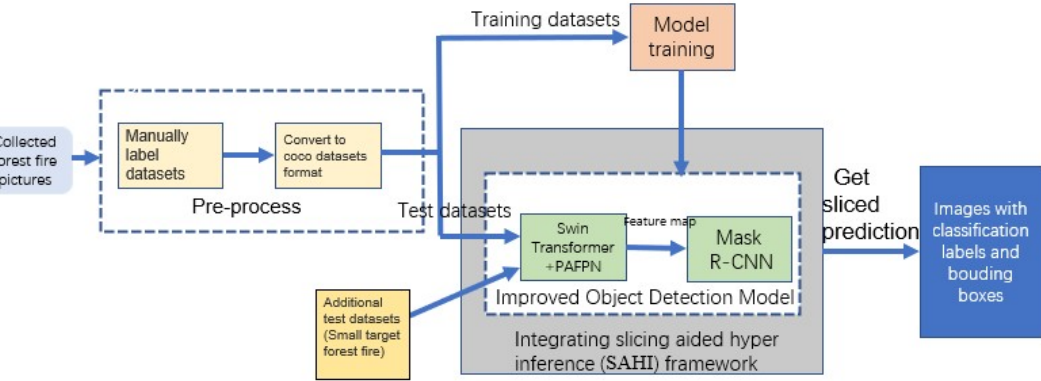
Figure 10. Overall structure of our small-target forest fire detection model STPM_SAHI.